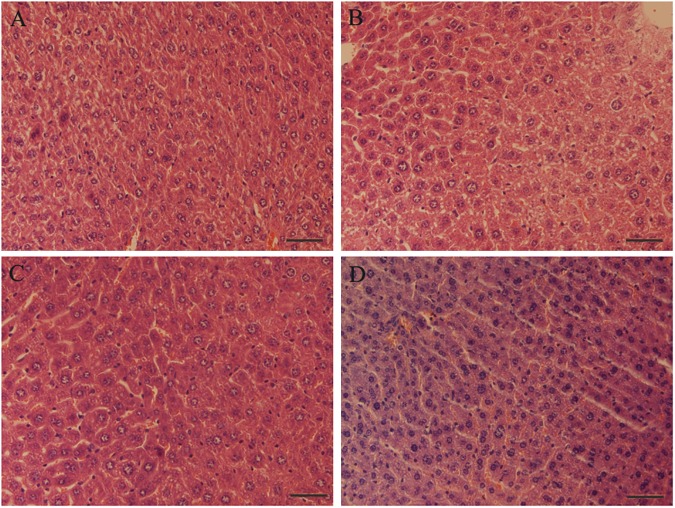
Hematoxylin and eosin (HE) staining of livers of mice in the four groups.(A) C57BL/Control; (B) ApoE-/-/Control; (C) ApoE-/-/GTP-L; (D) ApoE-/-/GTP-H (40× magnification, Bar = 100 μm), representative liver sections from mice.